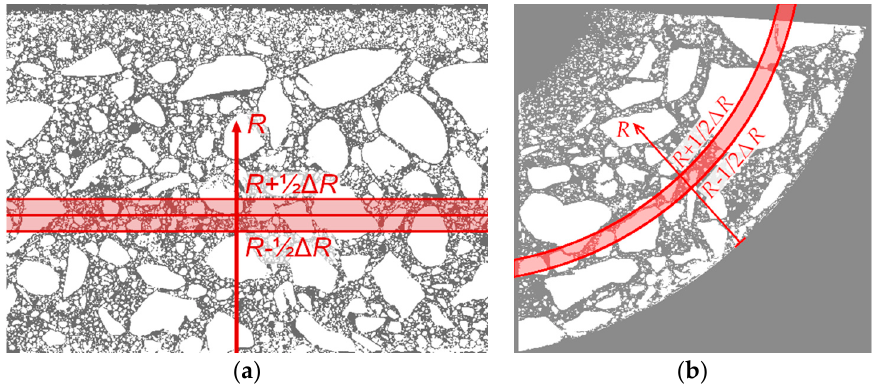
Figure 4. Selection of peripheral band: ( a ) in longitudinal section; ( b ) in cross-section [12].